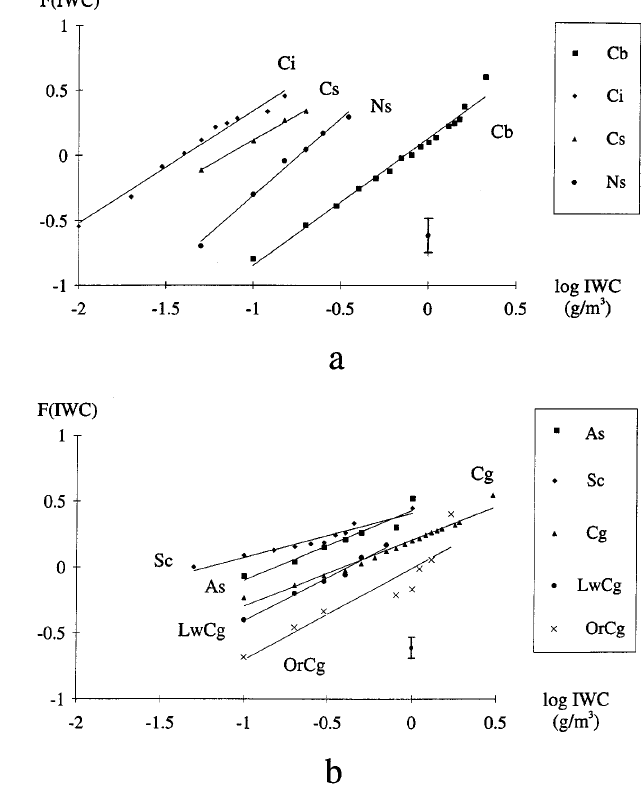
Fig. 7a, b. Cumulative frequency distributions of ice and water content ( IWC , in g m (cid:255) 3 ) and Weibull fitting: a for types Cb, Ci, Cs, Ns; b for types As, Sc, Cg, LwCg, OrCg. The error bar displayed is calculated using Eq. (16) and a relative accuracy of 10% on IWC . Its magnitude is roughly constant in the range of water